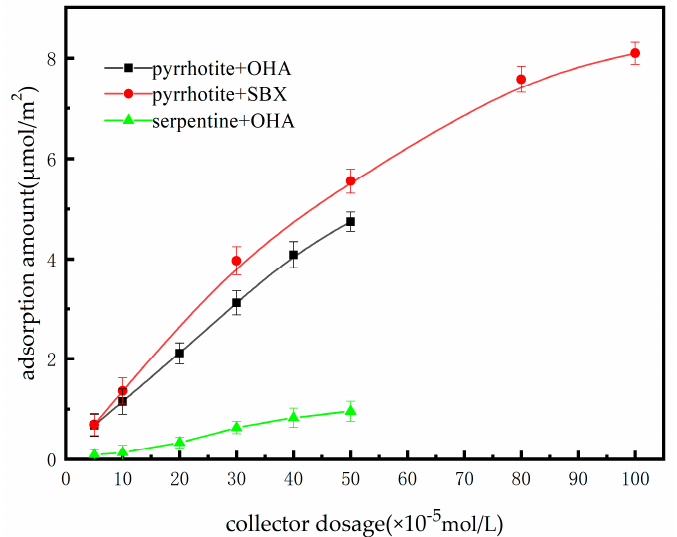
Figure 5. The adsorbed amount of the two collectors on the surfaces of pyrrhotite (ET = 24 h), as a function of the collector dosage (pH = 8.0).